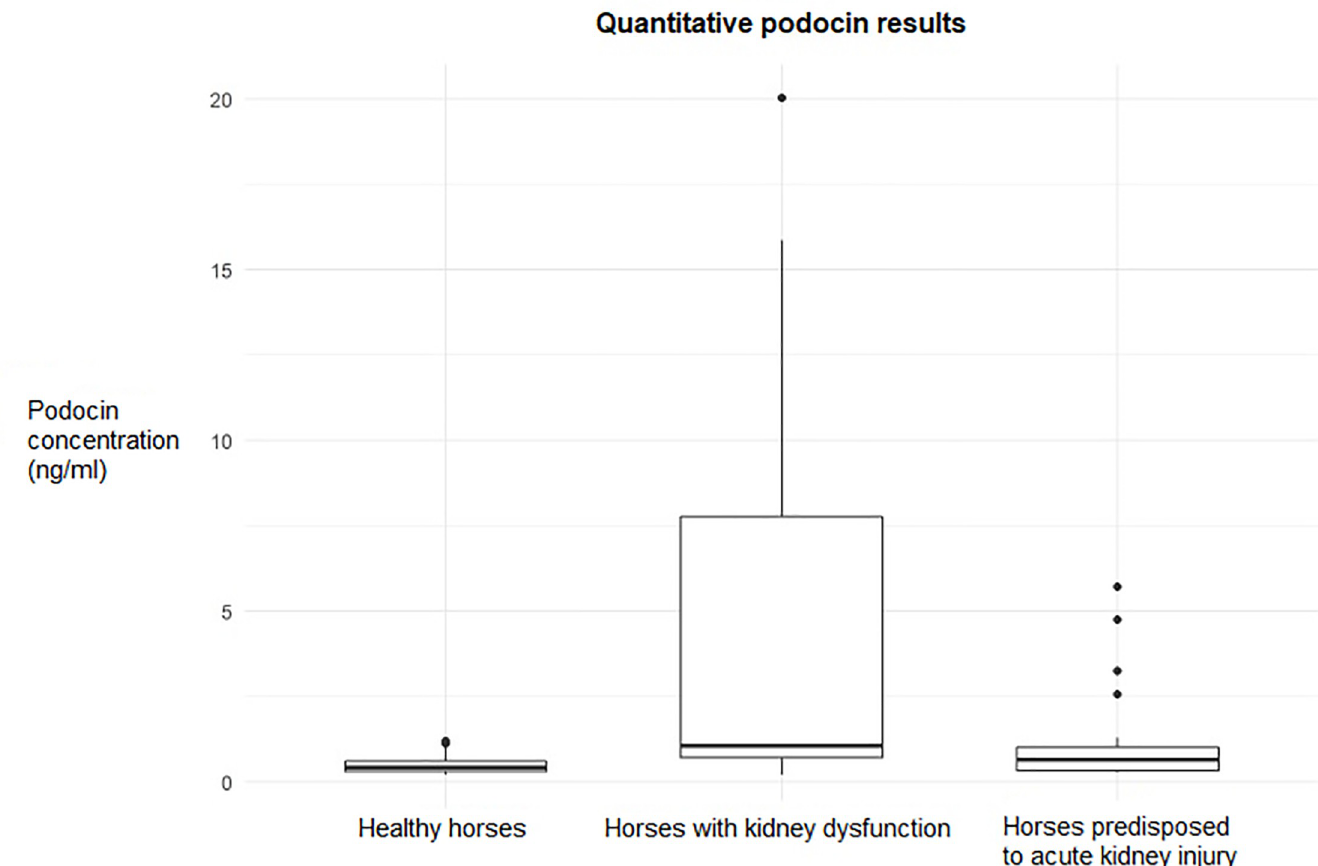
Fig 5. Graph showing results of the quantitative podocin ELISA test in healthy horses, horses with clinical kidney dysfunction and horses at risk for acute kidney injury.